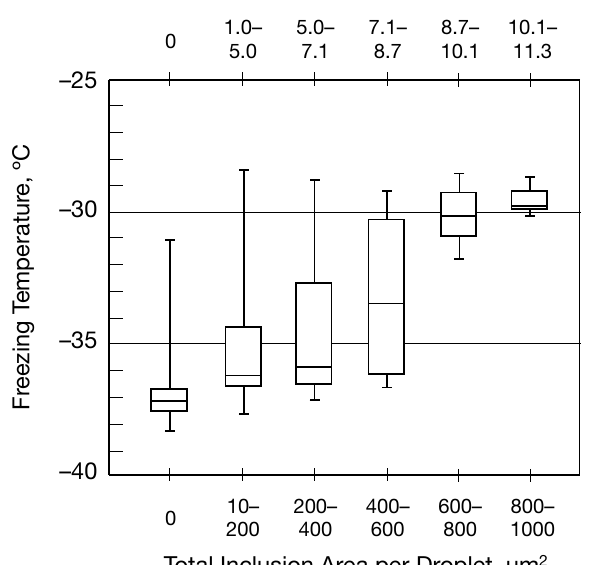
Fig. 8. Box plot showing a five-number statistical summary for homogeneous nucleation experiments (leftmost box) and binned data from all heterogeneous nucleation experiments. Each box represents temperatures as maximum and minimum values, and the 1st, 2nd (median), and 3rd quartiles. Freezing data are distributed into 200 µ m 2 bins that represent the total area of all observable inclusions per frozen droplet (bottom x -axis). The average uncertainty in the inclusion area is ±28 µ m 2 . Assuming that all inclusions are spores with a mean volume equivalent diameter of 3.2 µ m, the top x -axis provides the numbers of Cladosporium spores corresponding to each area bin.